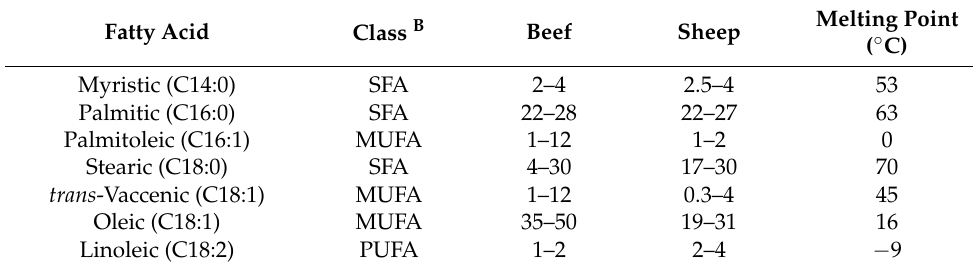
Figure 1. Visualization of the PLSDA model for a variety of model sets relevant to various carcass groups, reproduced from [28]. Table 2. Major fatty acids (% w/w ) in cattle and sheep A .